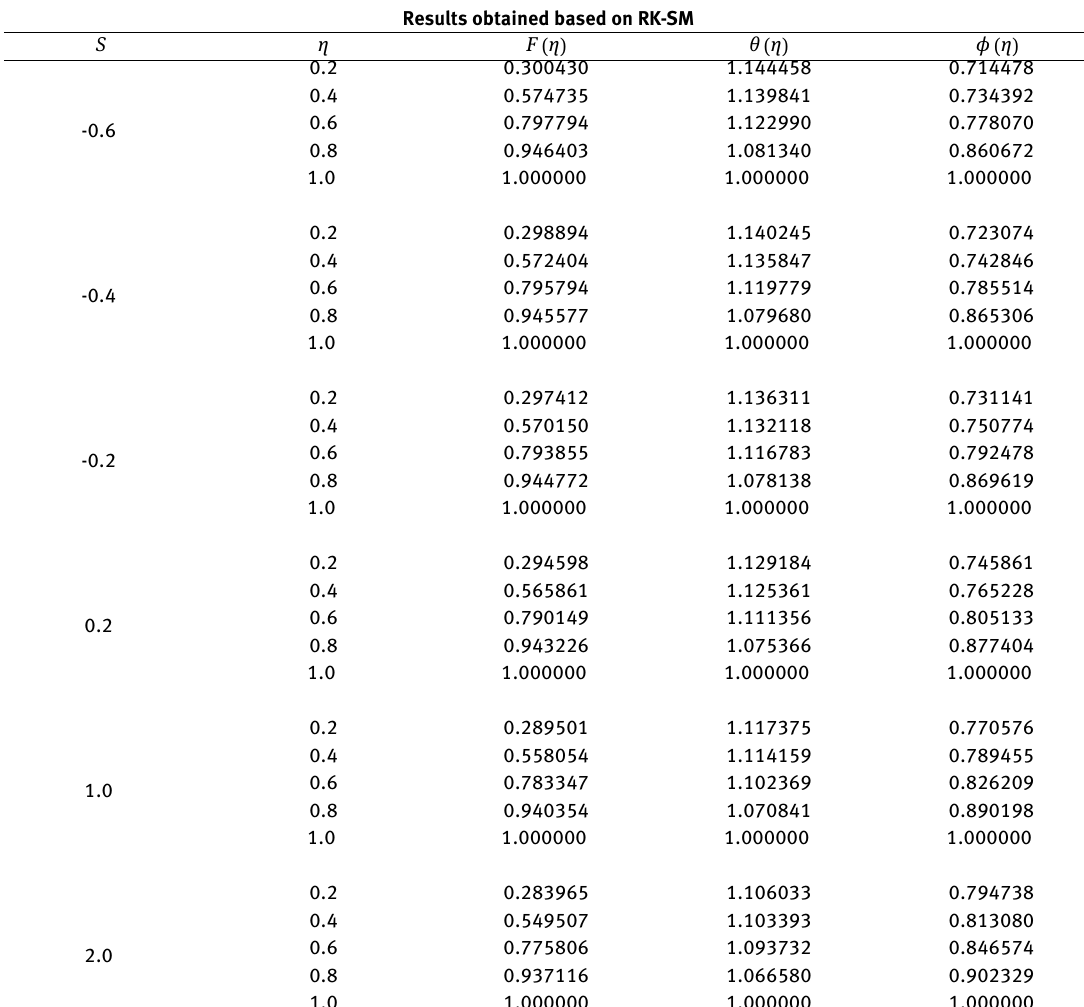
Table 2: Numerical values of F ( η ) , θ ( η ) and ϕ ( η ) for different set of S , obtained based on RK-SM technique with fixed values of Ha =